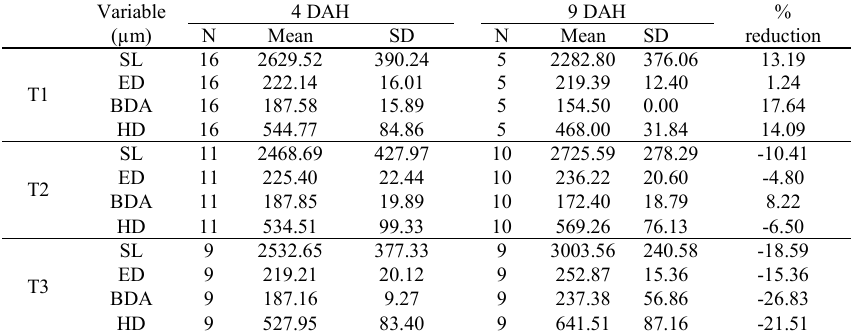
Table 1. Mean values of morphometrical variables and Standard deviation (SD) at four and nine days after hatching (DAH) of Pagrus pagrus larvae from the different feeding treatments. % reduction: difference between mean values of a certain variable obtained four DAH minus the corresponding to nine DHA, and expressed as a percentage; negative percentage means an increase in the mean value of a certain morphometrical variable. BDA: body depth at the anus, ED: eye diameter, HD: head depth, SL: standard length. T1: without food, T2: delayed feeding and T3: fed.